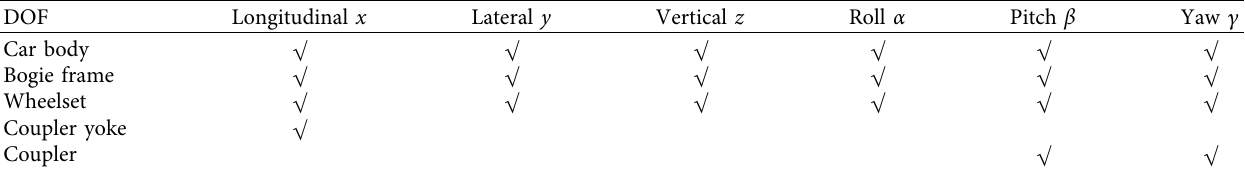
Table 1: DOF list of rigid body.